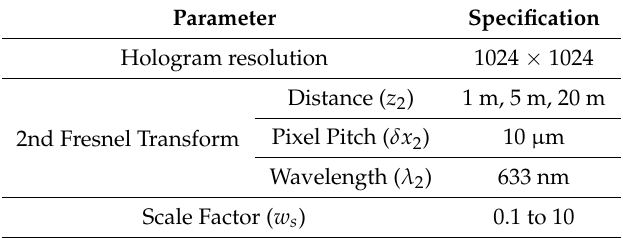
Table 2. Parameters used in the experiments for the digital hologram encryption.